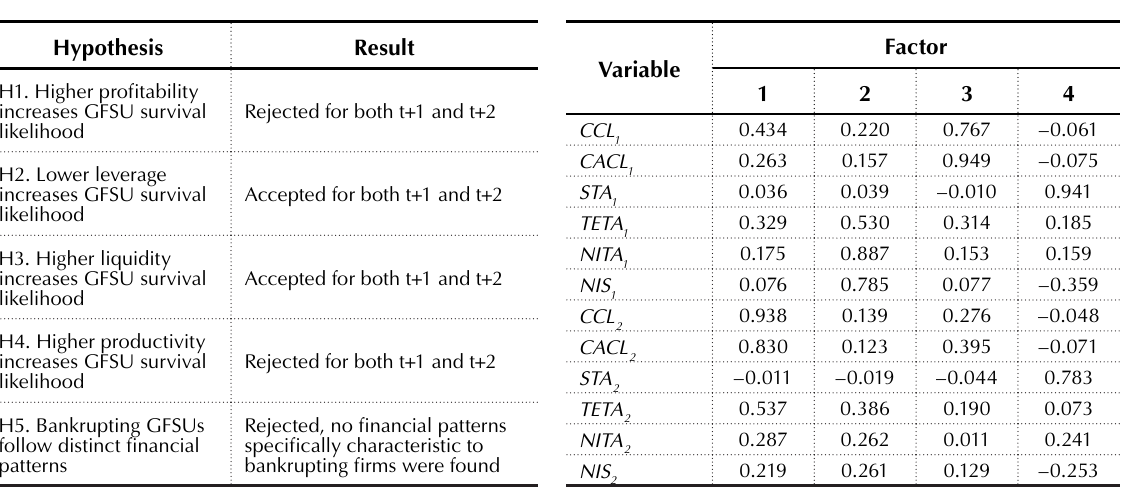
Table 7. Results of hypotheses testing Table 8. Rotated factor